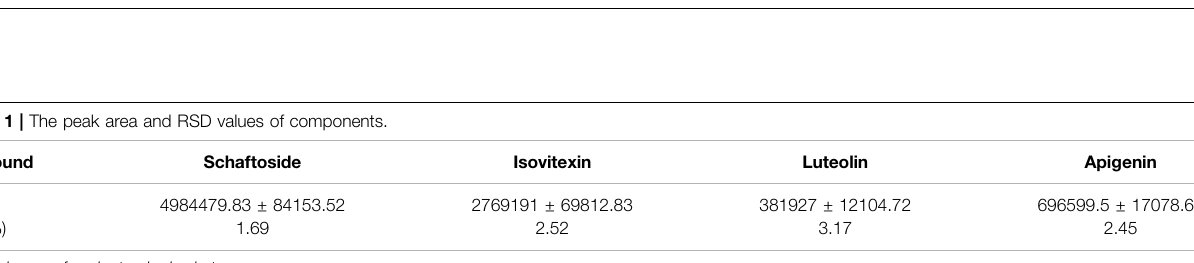
FIGURE 1 | The EICs and the MS/MS spectrum of standard substances and GS extraction. (A) EICs of four standard substances in positive mode. (B) Total ion chromatogramofGSextractioninpositivemode:a.Schaftoside,b.Isovitexin,c.Luteolin,d.Apigenin.Tandemspectrumofstandard,Schaftoside (C) andGSextraction (D) in positive